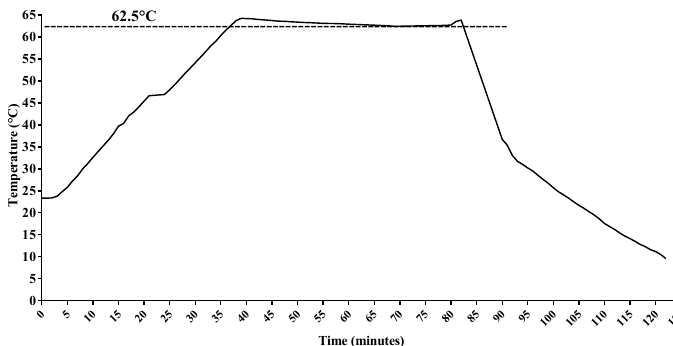
Figure 1. Time–temperature curve for Holder pasteurization method.